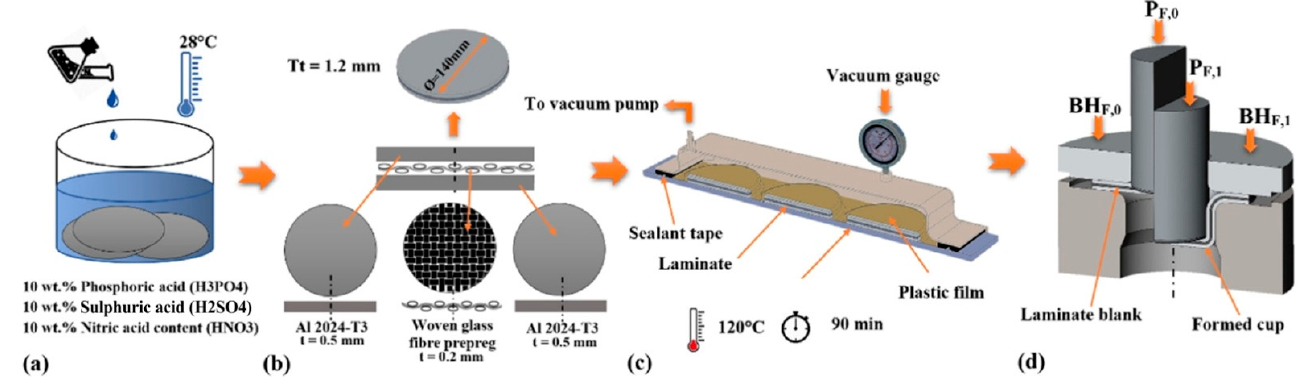
Figure 34. Preparation and forming of GLARE 2/1 using the conventional process: ( a ) surface treatment of 2024-T3 sheets, ( b ) 2/1 laminate assembly, ( c ) vacuum curing of blanks, and ( d ) forming (reproduced with permission from [86]; copyright© 2021 Elsevier Ltd.).